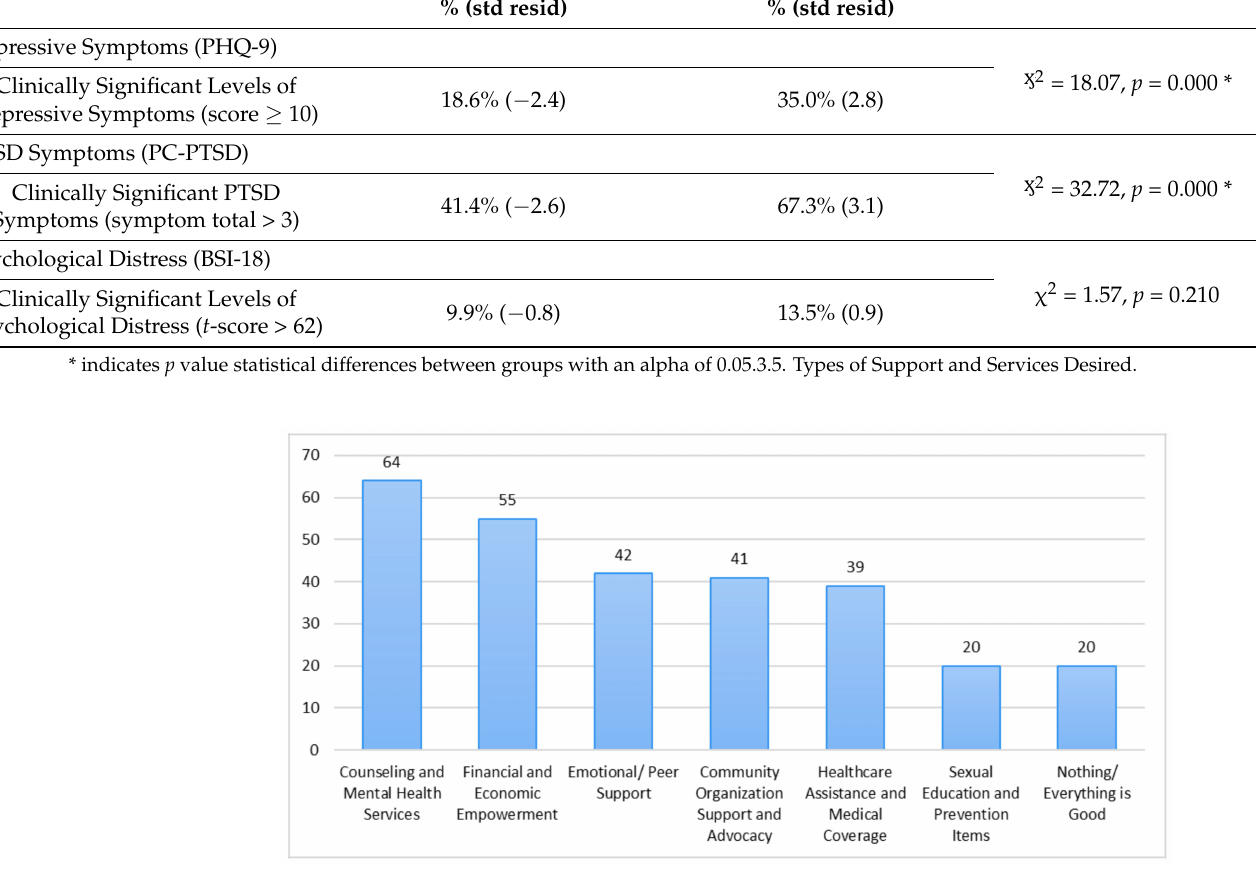
Table 3. Psychological Distress, PTSD Symptoms, Depressive Symptoms, IPV, SGMV, and Problematic Substance and Alcohol Use: Comparison across Sexual Orientation and Gender Identity (SOGI) groups.